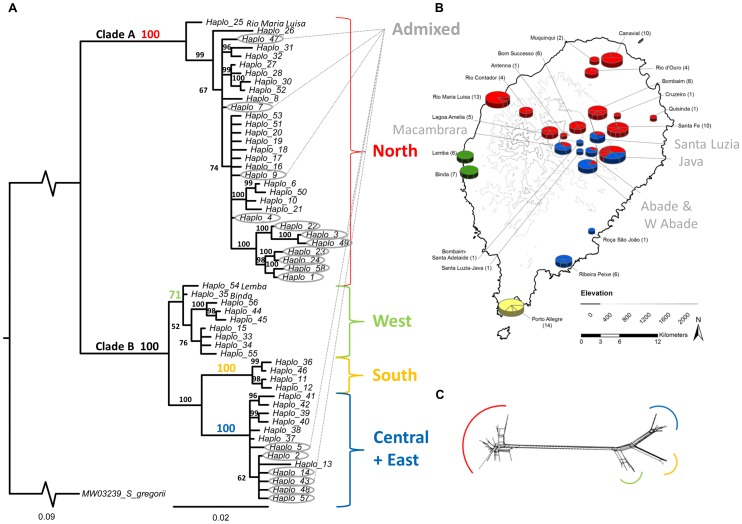
Genetic and geographic relationships of ND4 haplotypes.
A) Bayesian Phylogram (K80+G, 50% Majority-Rule Consensus Tree), with Bayesian Posterior Probabilities (PP) indicated above branches: Color-coding depicts groups “Admixed”, “North”, “West”, “South” and “Central+East” delineated by SAMOVA analysis. B) Genetic Map by Group displays relative size (
n
individuals) and haplotype composition of population samples within each group (each pie slice represents one haplotype); bicolored pie charts and gray text indicate admixed populations. C) SplitsTree Neighbor-Net illustrates relative distance between haplotype groups based on uncorrected pairwise genetic distance. Each line represents the connection between two haplotypes with the thicker lines representing many connections.